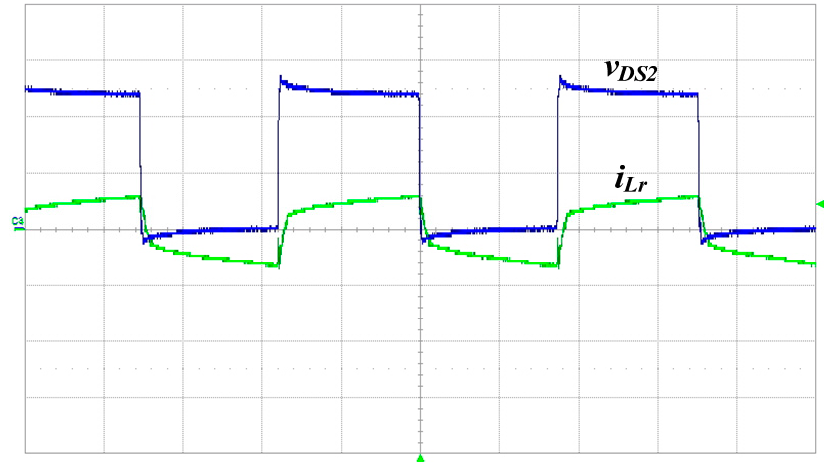
Figure 11. Measured switch voltage v DS 2 (200 V/div) and resonant inducotr current i Lr (2 A/div); time scale: 5 μ s/div.